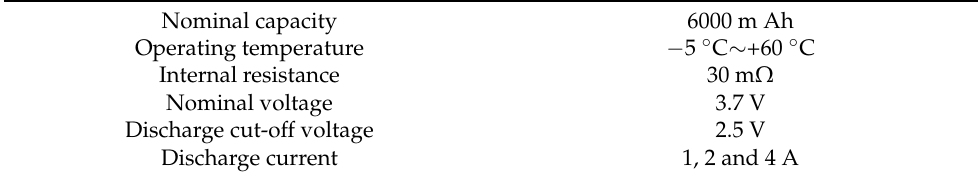
Table 1. Electrical Characteristics Of The Battery 18.650.